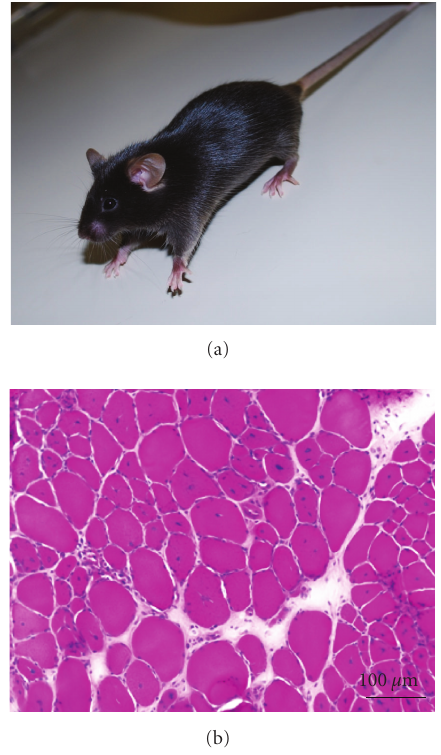
Figure 1: (a) A male mdx 52 mouse at 6 weeks of age. The generalized appearance is almost normal. (b) The pathology (H and E) of the tibialis anterior muscle shows multicentrally nucleated fibers with an increased extent of invasion of inflammatory cells and the interstitial space. Hypertrophic muscle fibers were also